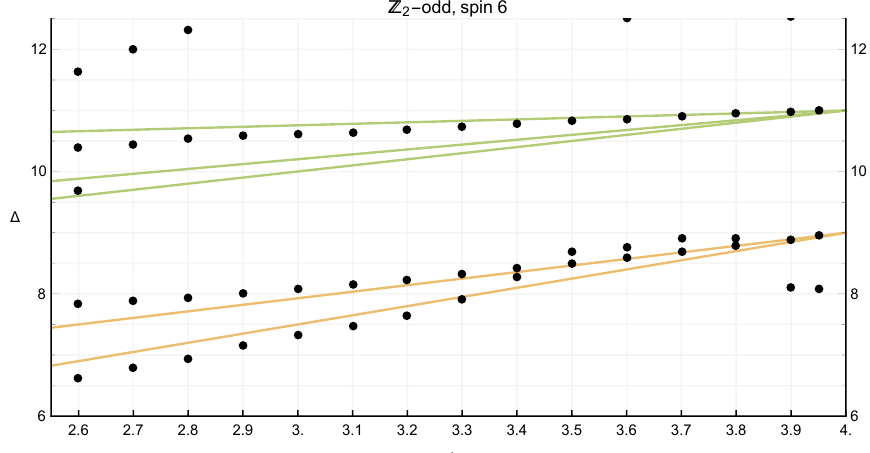
Figure 17 . Z 2 -odd operators of spin 6.